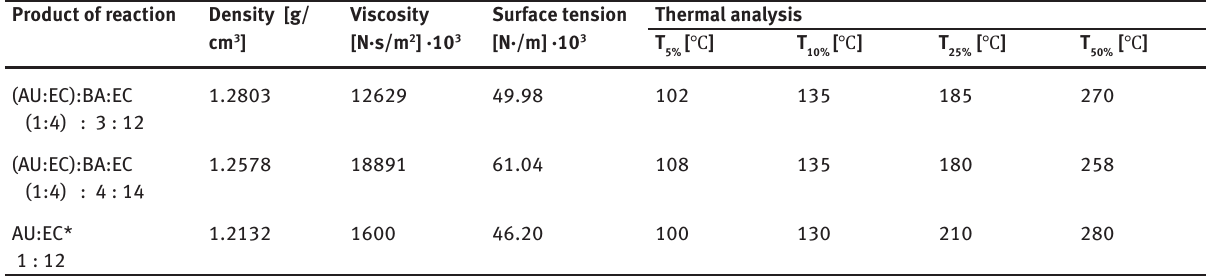
Table 2: The physicochemical and thermal properties of oligoetherols. Product of